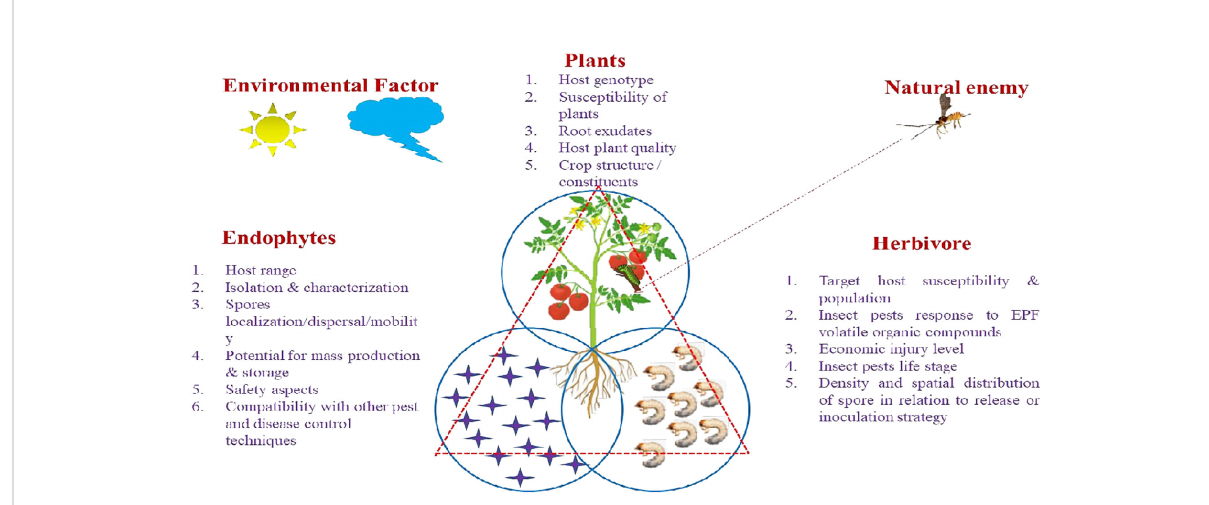
FIGURE 2 Speci fi c Factors affecting EEPF- plant – insect interactions. The tritrophic interactions involving EEPF-colonised host plants-insects-natural enemies are dependent on diverse biotic factors (fungal features of EEPFs, plants, the associated herbivores) and abiotic factors (environmental factors). Biotic factors: 1. Fungal features: include epizootic potential (Spores germination, Sporulation and Virulence), persistence, host range, isolation and characterization, spores localization/dispersal/mobility, potentials for mass production, suitability for storage and formulation, fungal toxicological and safety aspects, compatibility with other pest and disease control techniques. 2. Host features: Target host susceptibility & population, insect pests response to EPF volatile organic compounds, economic injury level, insect pests life stage, density and spatial distribution of spore in relation to release or inoculation strategy. Abiotic factors: 1. Environmental factors: Relative humidity (RH), temperature, soil moisture and pH, rain, irrigation, dew drops, solar ultraviolet radiation